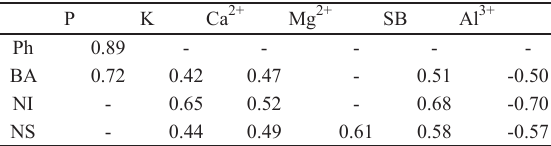
Spearman correlation between soil and vegetation variables.